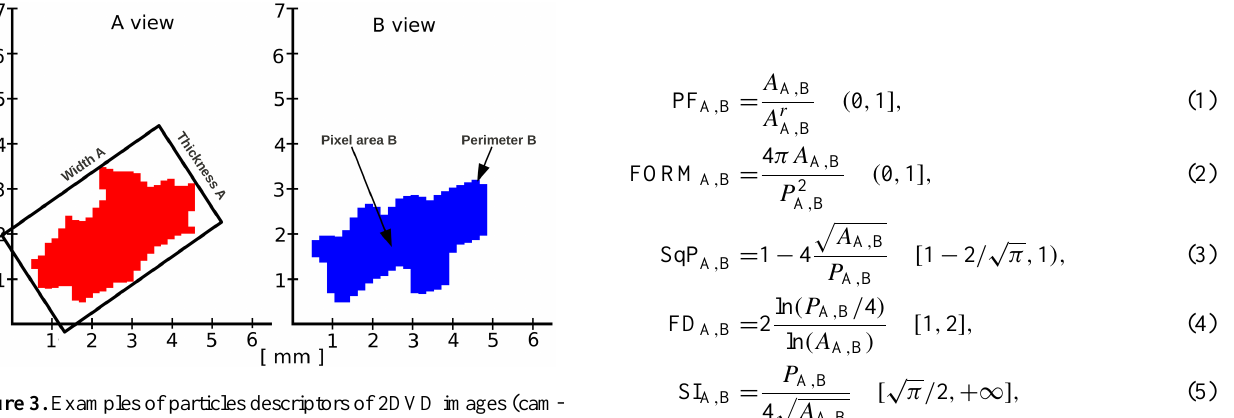
Figure 3. Examples of particles descriptors of 2DVD images (cam- era A and B). On camera A: width ( W A [mm]) and thickness ( T A [mm]) of the bounding box enclosing the particle. On cam- era B: particle apparent perimeter ( P A [mm]) and shaded area ( A A [mm 2